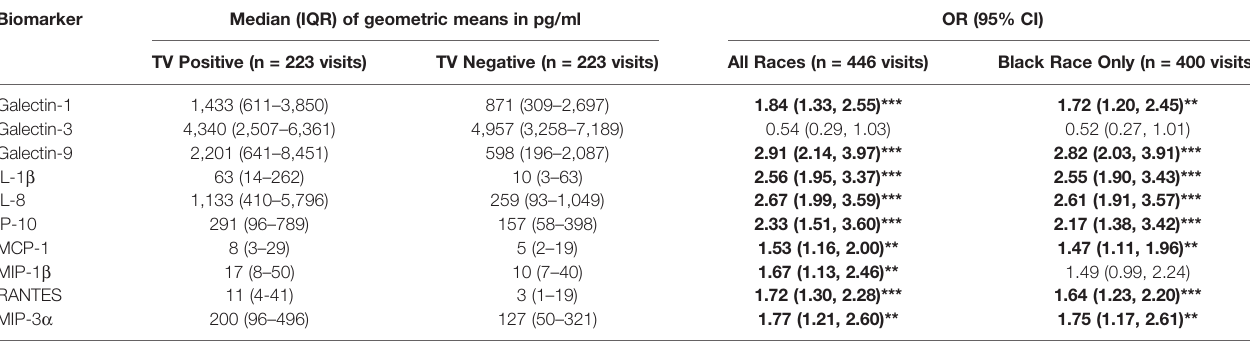
Medianandinter-quartileranges(IQR)ofback-transformedgeometricmeansofconcentrationsofimmunemediatorsandoddsratios(OR)and95%con fi denceintervals(CI)forincident T. vaginalis (TV) with each 1 log 10 unit higher level of immune mediator are calculated from conditional logistic regression models fi tted using generalized estimating equations. Signi fi cantly different ORs are bolded and indicated by **p < 0.01 and ***p < 0.001.